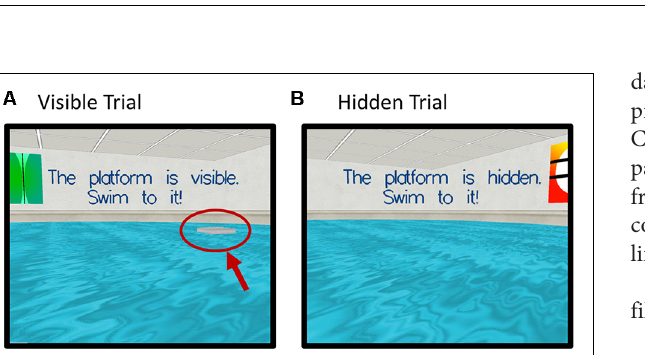
FIGURE 1 | Schematic representation of the testing timeline for the treatment visits.